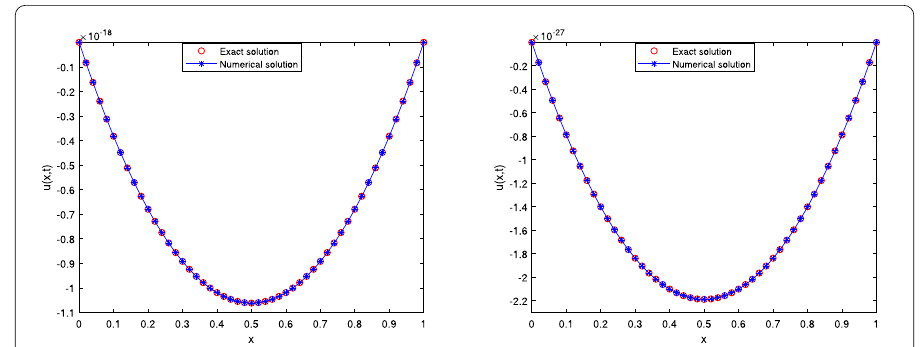
Figure 3 Approximate and exact solutions of Example 6.1 for n = 5 with final times T = 20 (left), T = 30 (right), and φ ( h ) = 2sin( h /2)